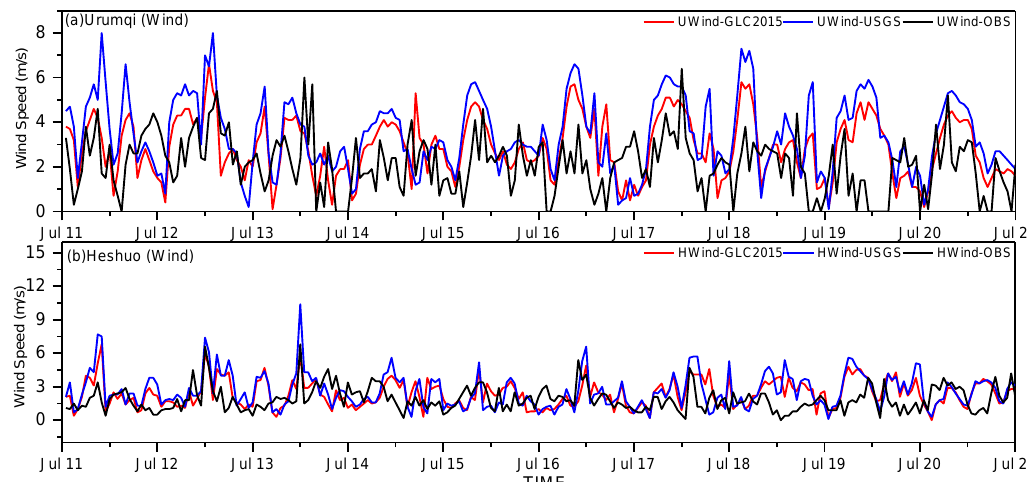
Figure 9. Simulated and observed wind speeds at ( a ) Urumqi and ( b ) Heshuo. GLC2015 (red line), USGS (blue line) and observational (black line) data are shown.